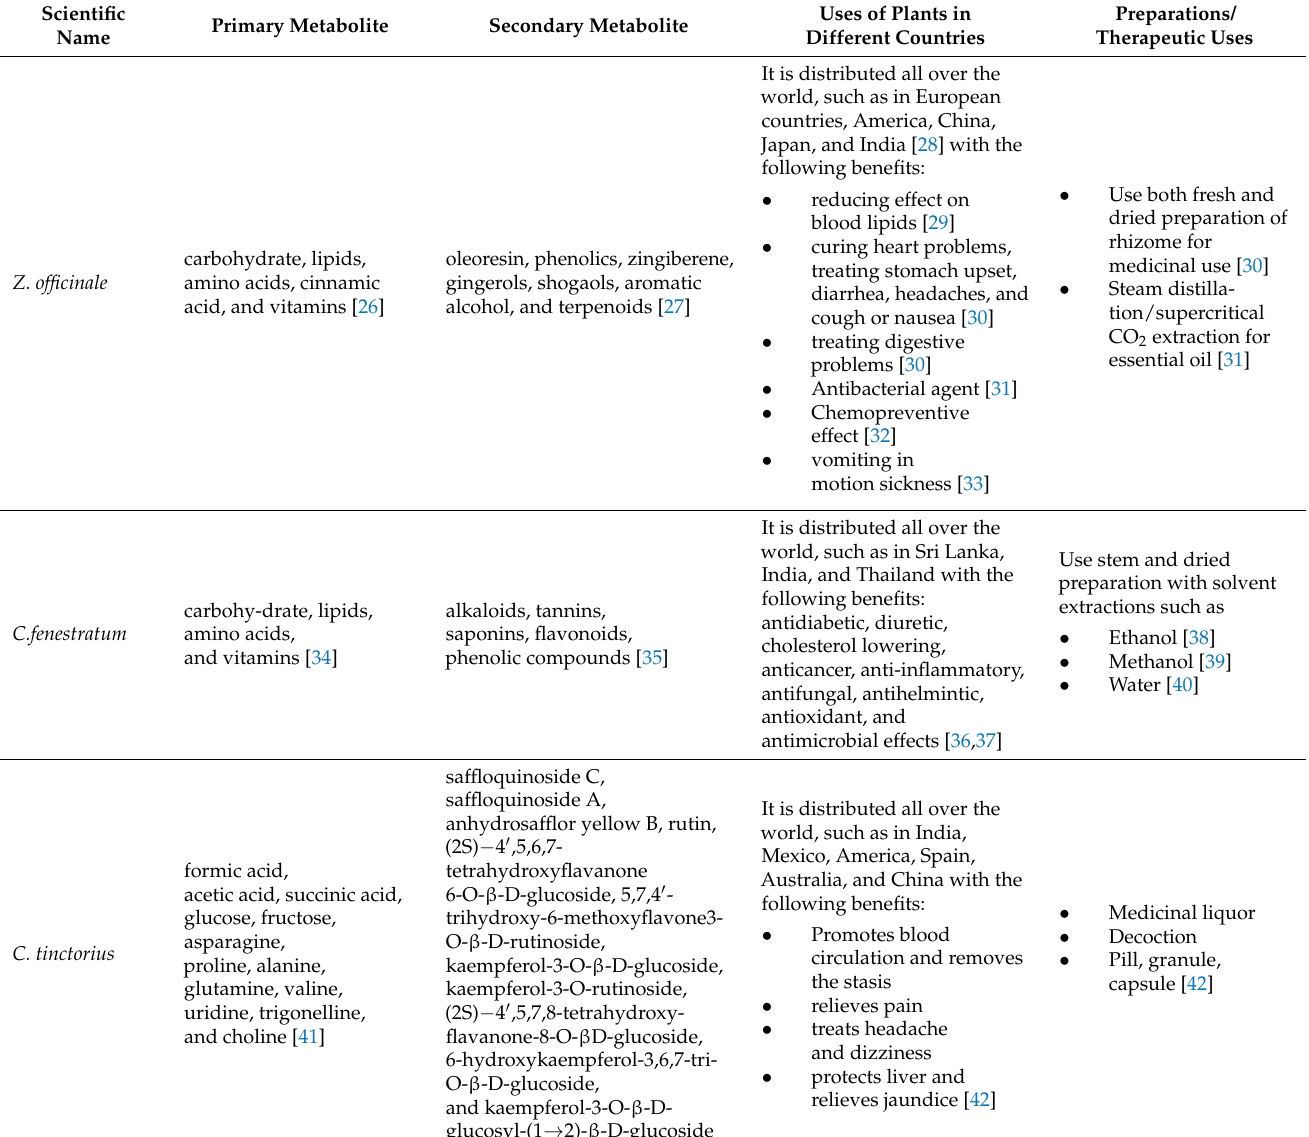
Table 1. Primary and secondary compounds derived from plants and their therapeutic uses in different